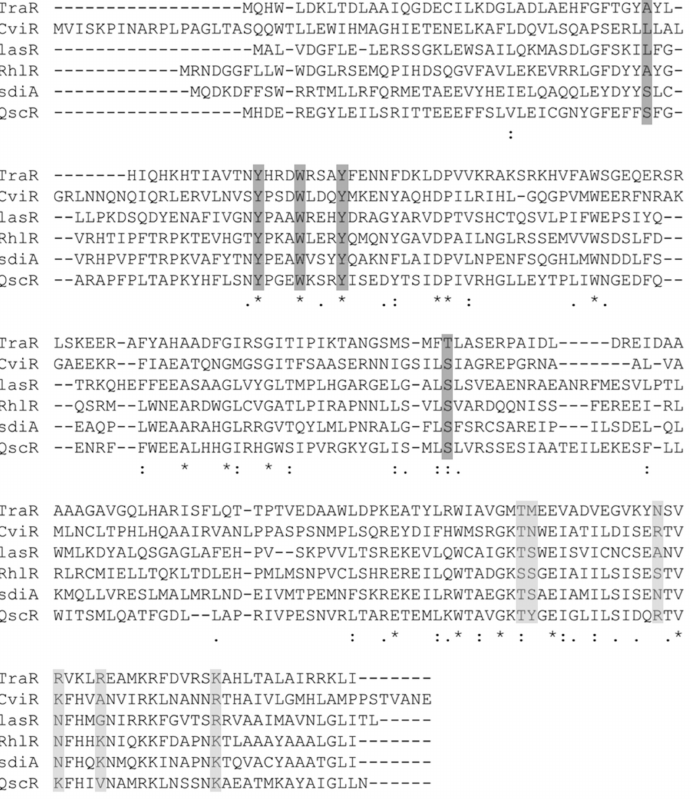
Figure 8. MSA analysis of QS regulators to compare the residue of the active site and the DNA- binding site. Sequence alignment of the QS regulator results in output using MUSCLE. Positions highlighted in dark gray are the residues involved in h-bond formation at the active site and those in light gray are the reference sites for DNA binding as per TraR structure